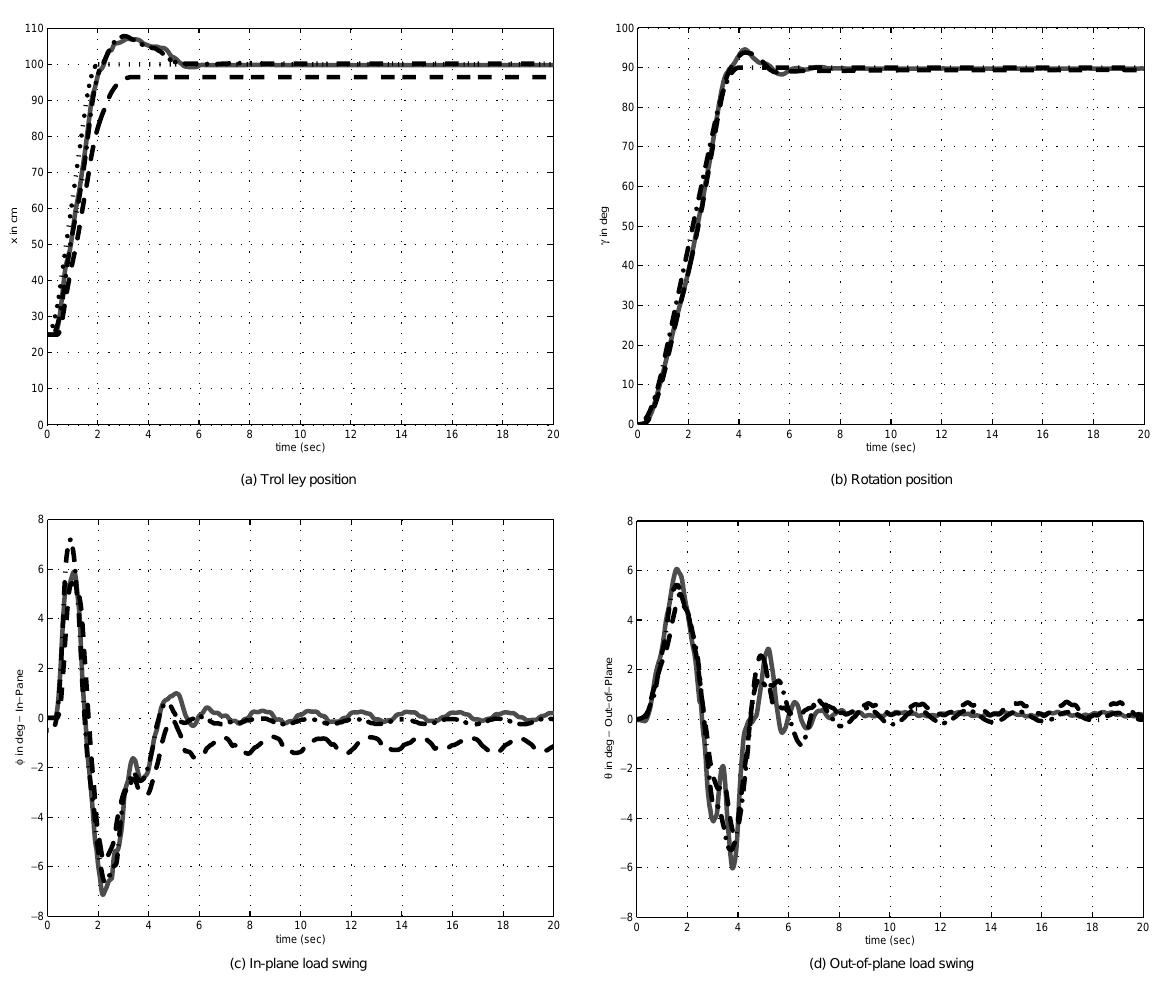
Fig. 15. Time histories of the combined motion: —— fuzzy with friction compensation, - - - - fuzzy without friction compensation, -.-.-.- delay with friction compensation, and . . . . . reference trajectory. increases with increasing trajectory acceleration. The maximum acceleration should be chosen properly. Otherwise using high acceleration would lead to an increase in the overshoot and the swing angles while the system settling time would remain the same [29]. Without friction compensation, the system would have a high steady-state error and a high load swing, and hence it would take a long time to damp. When friction compensation was turned on, the system reached its destination nearly without steady-state error and the load swing was suppressed successfully.